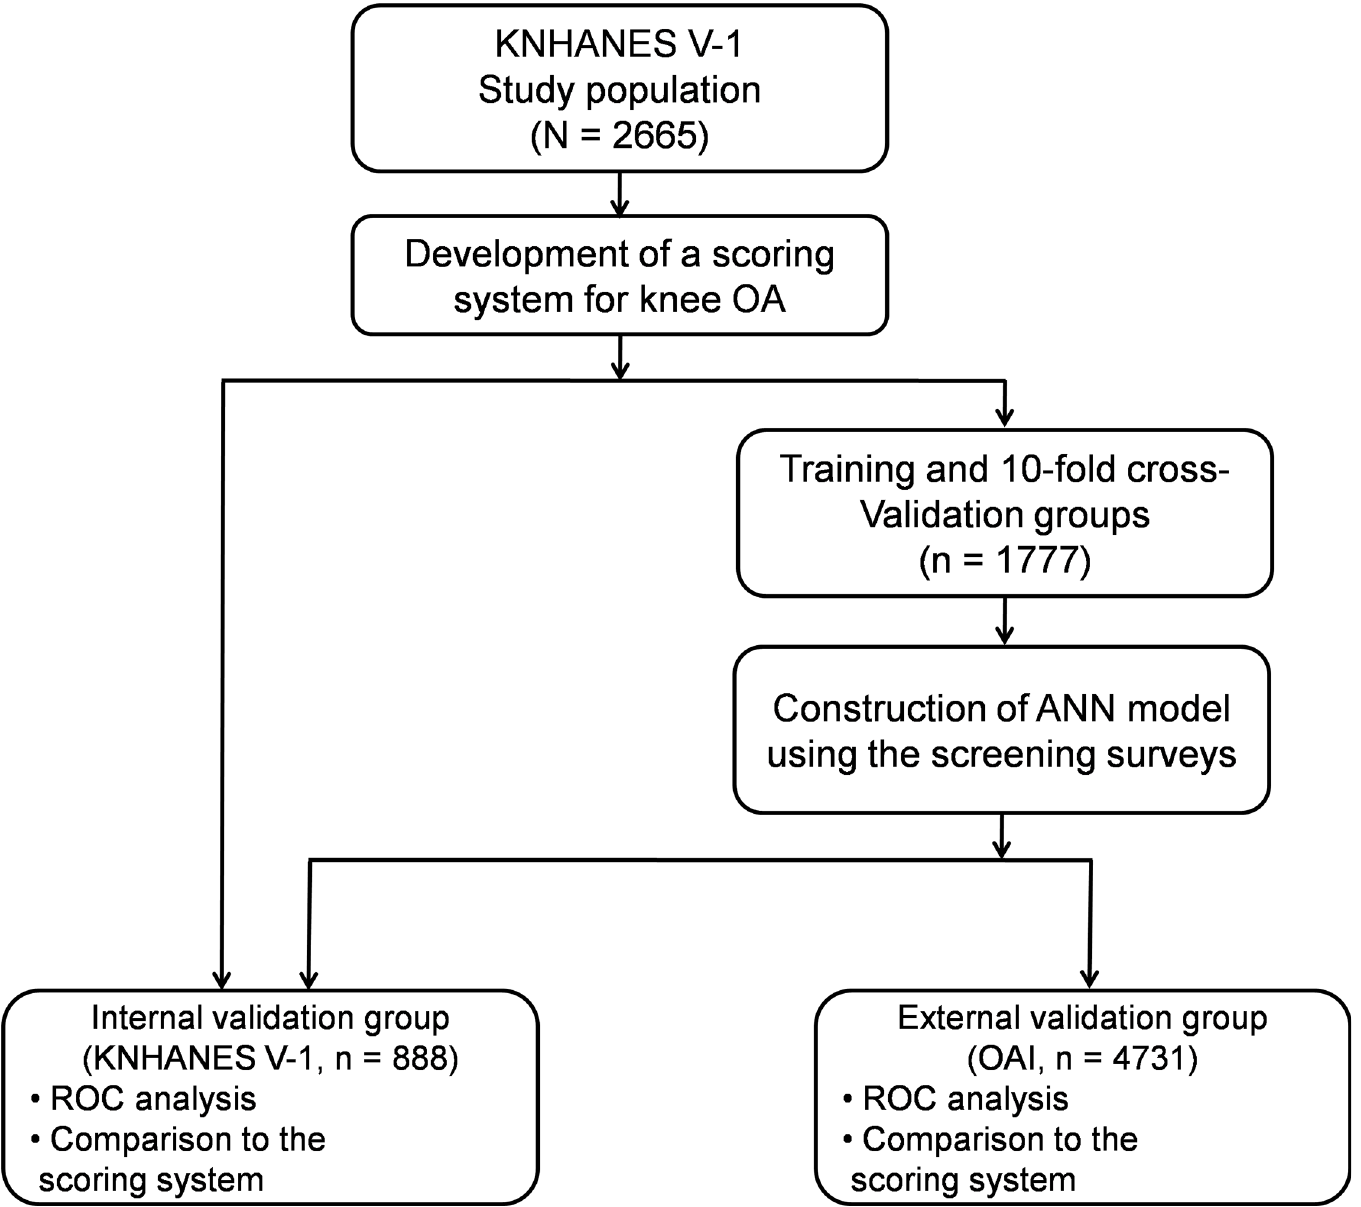
Fig 1. Dataset used in the development and validation for knee osteoarthritis risk prediction. ANN, artificial neural network; KNHANES, Korea National Health and Nutrition Examination Survey; OA, osteoarthritis; OAI, Osteoarthritis Initiative; ROC, receiver operating